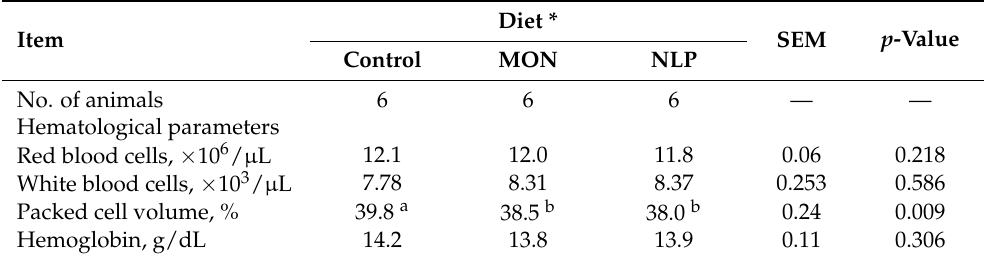
Table 5. Influence of neem leaf powder or monensin supplementation on blood parameters and fecal egg count of Omani growing